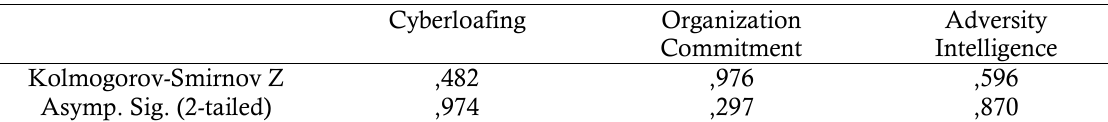
Table 1. Normality Test